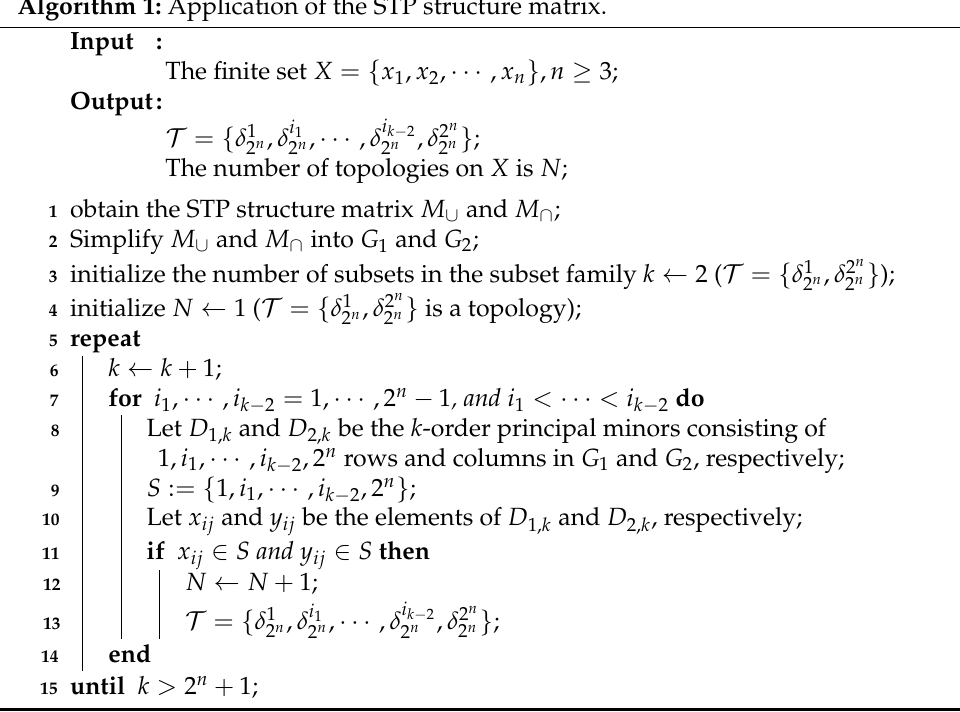
Algorithm 1: Application of the STP structure